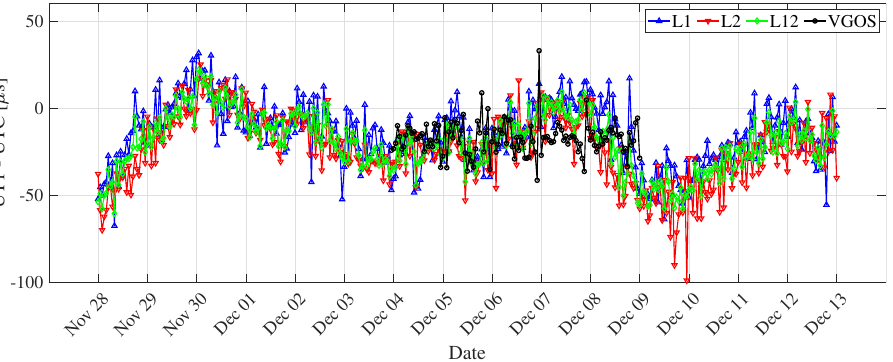
Figure 6. dUT1 estimates with respect to finals.all (IAU2000) derived from L1, L2, and L12 networks, and VGOS networks for hourly resolution (using global solutions).